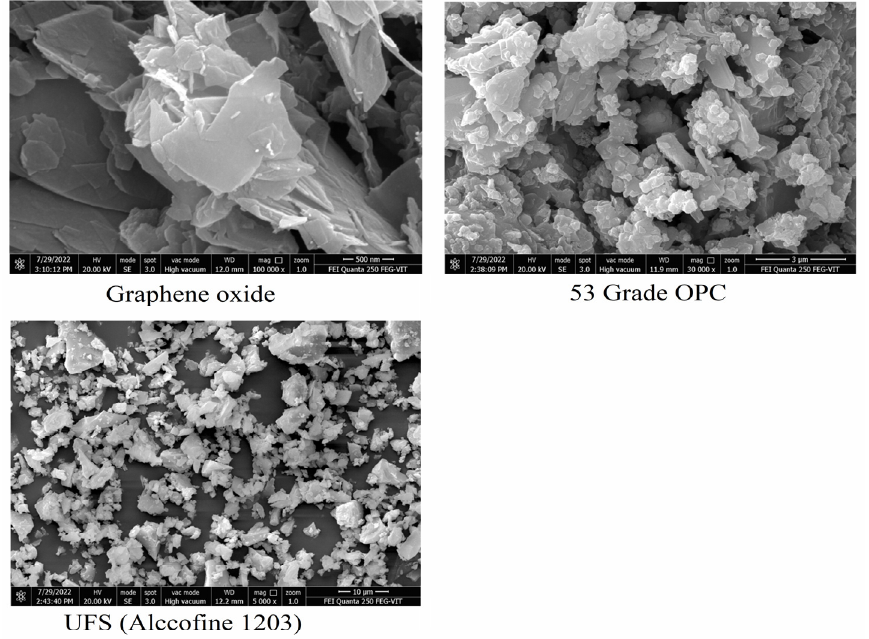
Figure 5. SEM images of GO, 53 grade OPC, and UFS (Alccofine 1203).